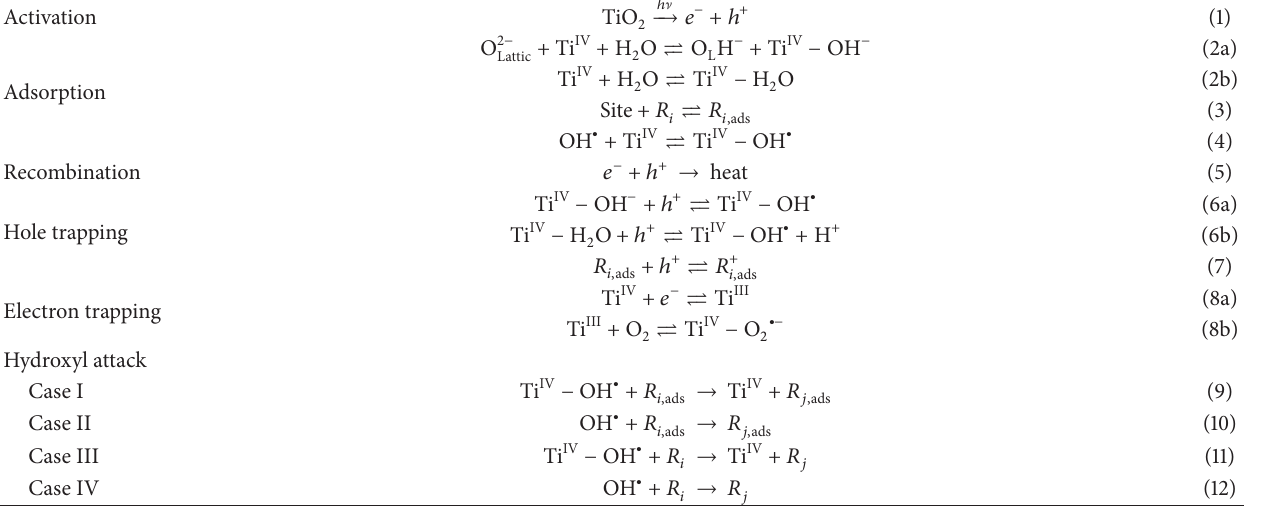
Table 1: Heterogeneous photocatalysis reaction scheme based on semiconductor TiO